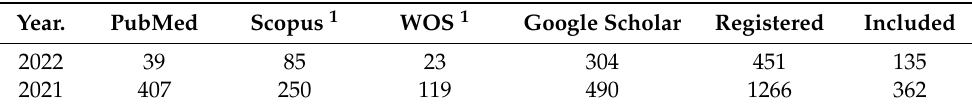
Table 3. Results of synthesis for AI-focused dental papers (1 January 2021–19 April 2022) included for qualitative